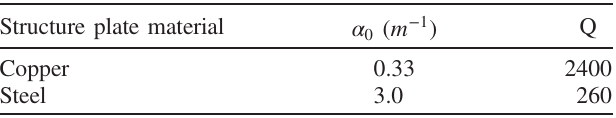
TABLE II. Comparing the field decay factor and quality factor (for the fundamental mode) of a steel and copper metamaterial structure.